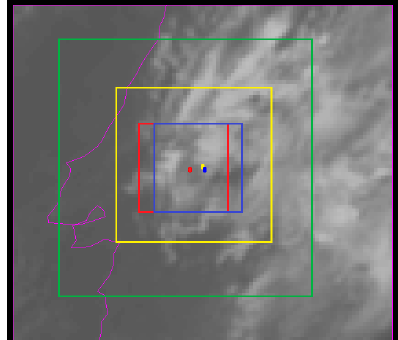
Figure 6. A low resolution tracer for 16 December 2009 11:45 UTC (red square, with its center in the red mark), the location of its center defined by NWP wind guess at 12:00 UTC (yellow mark), and its true tracking center at 12:00 UTC defined by NWC / GEO-HRW product (blue mark), for an example case of AMVs with MSG-2 satellite. The yellow square (with its center at the position defined by the NWP wind guess at 12:00 UTC) corresponds to the tracking area using the wind guess for its definition. The green square (with its center at the position of the tracer at 11:45 UTC) corresponds to the tracking area not using the wind guess for its definition. The larger size of the tracking area when the wind guess has not been used is to be noticed, which causes a longer time for the running of NWC / GEO-HRW product, but at the same time reduces the dependence from the NWP model.